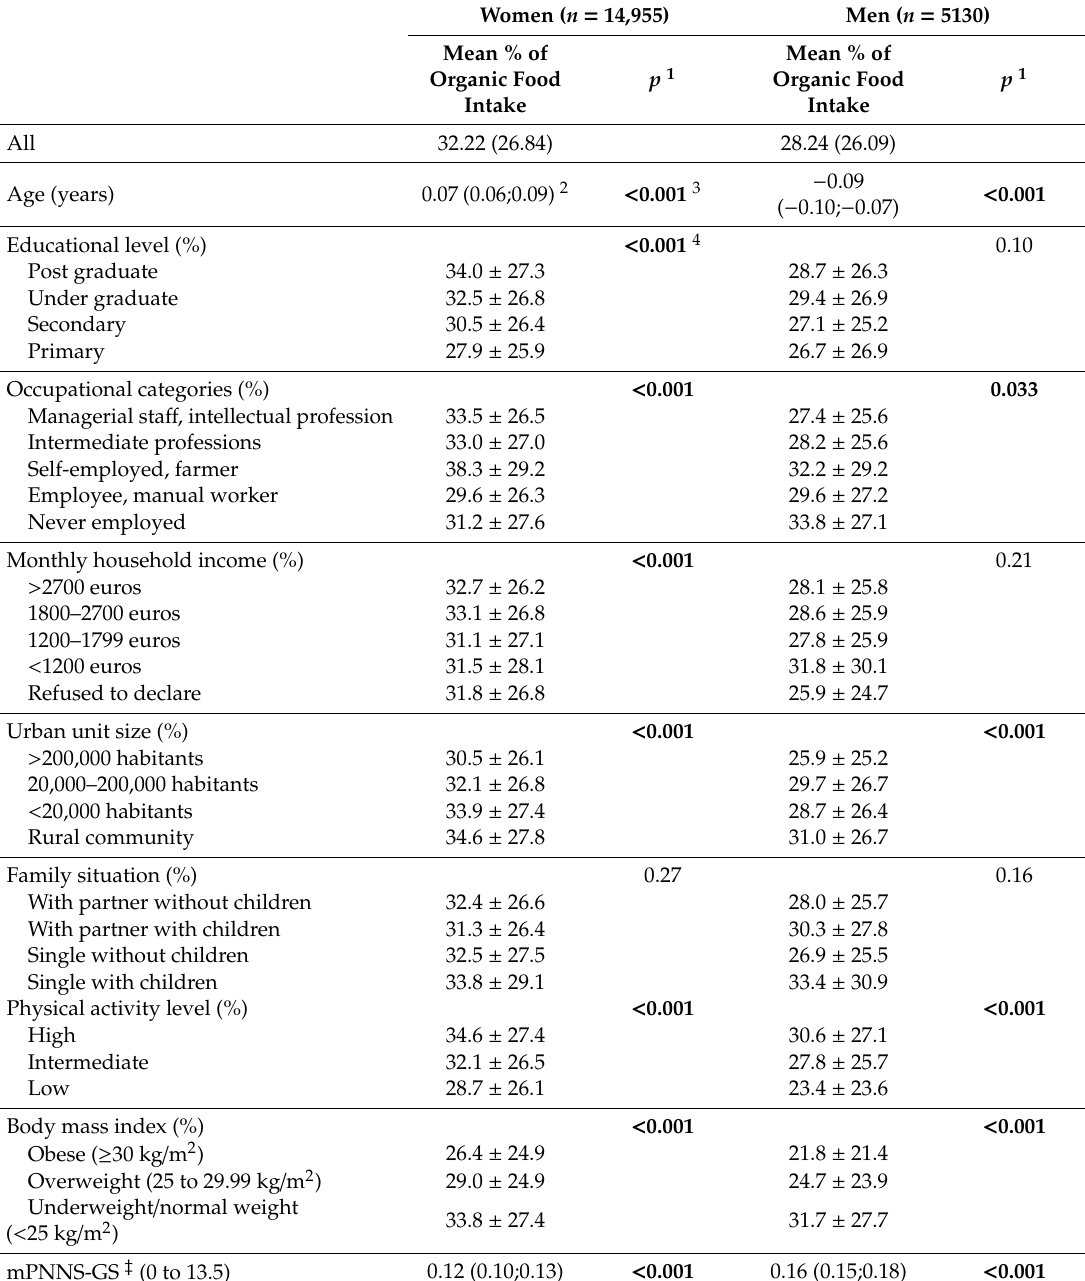
Table 2. Mean percentage of overall organic food intake out of total food intake according